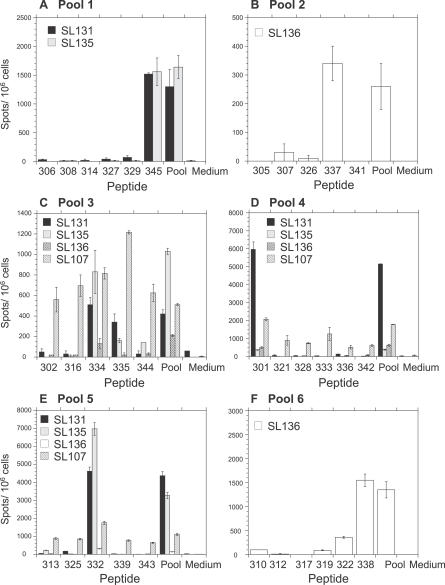
Fine Specificity of TCLs Generated in Vaccinated and Infected DonorsFine specificities were determined by IFN-γ ELISPOT using as antigen individual peptides included in a given pool. (A) Peptide pool 1; (B) peptide pool 2; (C) peptide pool 3; (D) peptide pool 4; (E) peptide pool 5; and (F) peptide pool 6. Background responses (wells in which peptide was not added) were on average less than 22 spots per 106 cells (range 2 to 34).